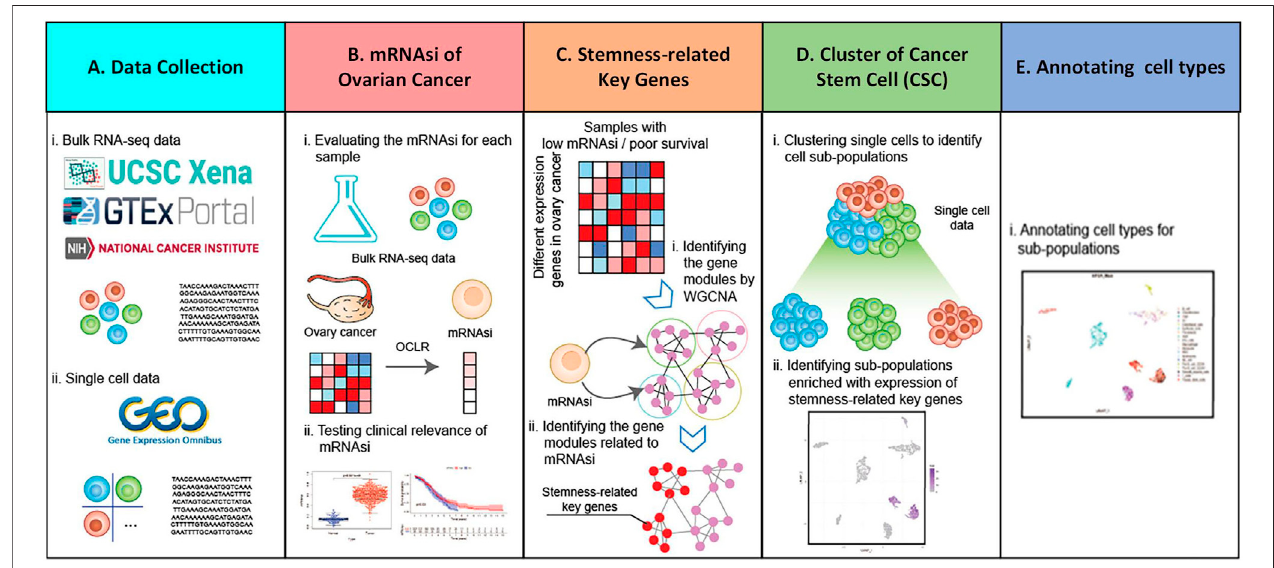
FIGURE1| Holisticapproach. (A) Datacollection. (B) mRNAsiofovariancancerbulkRNA-Seqsampleiscalculatedandanalyzed. (C) Accesstostemness-related key genes. (D) Single-cell data of ovarian cancer are analyzed using Seurat and SingleR package. (E) Annotation cell types for